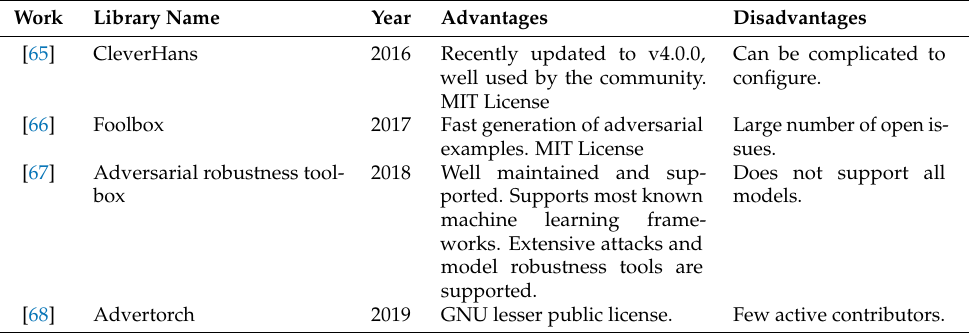
Table 3. Libraries for Generating Adversarial